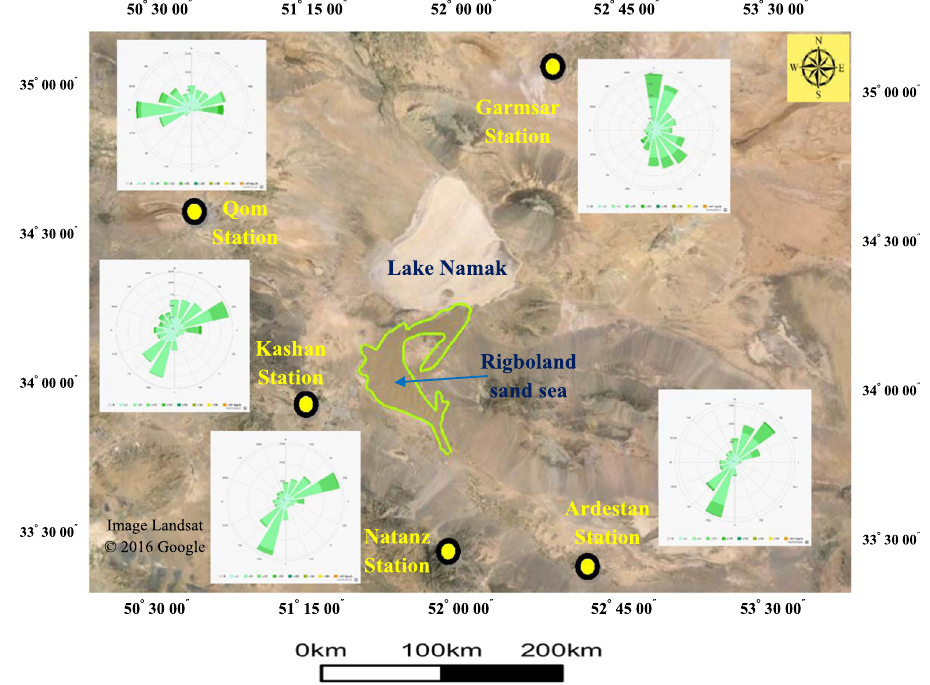
Figure 6. The location of five weather stations around the Rigboland sand sea. The wind roses show the annual distribution and magnitude of wind direction and speed (Image from Google Earth